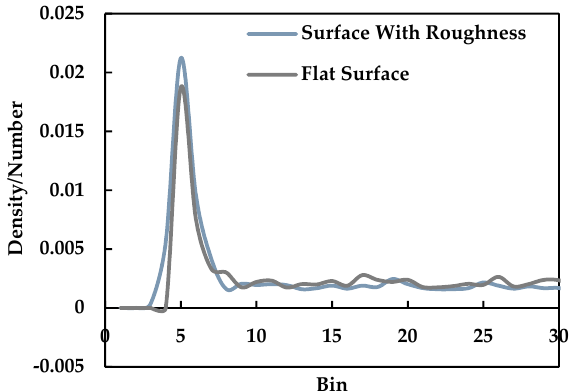
Figure 20. Comparison of density profile of argon at 4 ns for nano level roughed surface with a smooth surface.